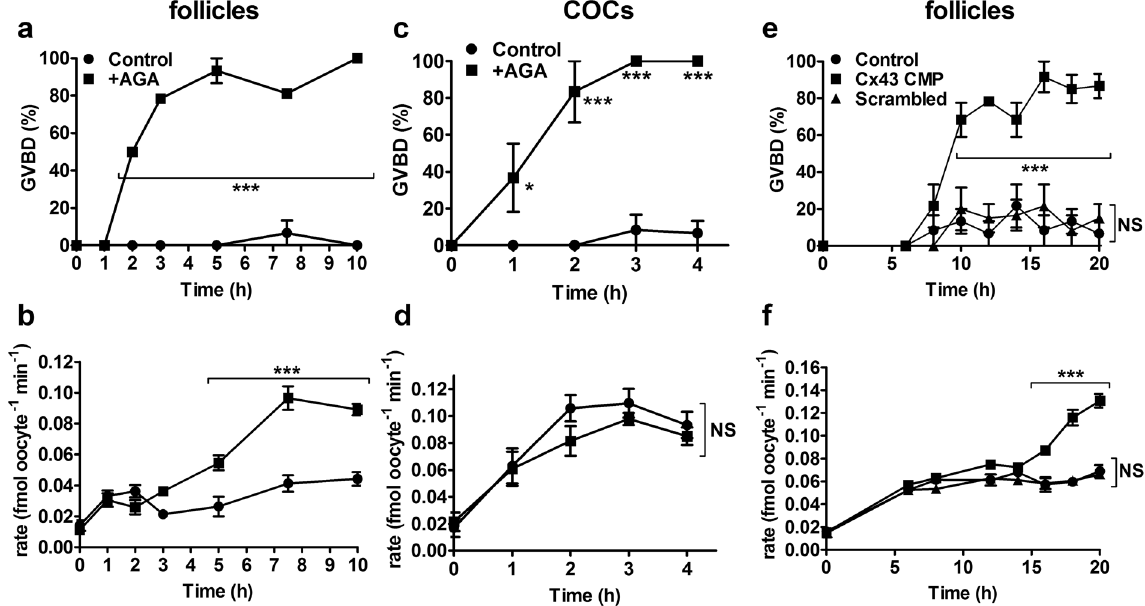
Figure 3. Effect of blocking gap junction permeability on GLYT1 activation. ( a ) Time course of GVBD in oocytes isolated from punctured antral follicles that had been cultured for the period indicated in the presence or absence of the gap junction blocker, AGA (150 µ M). Means were significantly different for all time points from 2–10 h inclusive. ( b ) GLYT1 activation as a function of time in the presence or absence of AGA in the same oocytes as in ( a ). GLYT1 activity was significantly increased starting at 5 h, with partial activation at 5 h and full activation at 7.5 and 10 h. Each point represents the mean ± s.e.m. of three independent repeats at each time (in A and B). ( c ) Time course of GVBD in oocytes isolated from COCs cultured with or without AGA identically to the antral follicles in ( a ). Significant GVBD occurred starting at 1 h and was maximal by 2–3 h. ( d ) GLYT1 activity in the same oocytes as in ( c ). There was no significant difference in the presence vs. absence of AGA. Each point represents the mean ± s.e.m. of three independent repeats at each time (in c and d ). ( e ) Time course of GVBD in oocytes isolated from punctured antral follicles in the presence of no addition (Control), Connexin Mimetic Peptide directed against Connexin 43 (Cx43 CMP) or a scrambled peptide. GVBD was significantly increased only by 10 h only in the Cx43 CMP treated group. ( f ) GLYT1 activity in the same oocytes as in ( e ) did not increase significantly until starting at 16 h only in the Cx43 CMP group. Each point represents the mean ± s.e.m. of three independent repeats at each time (in e and f ). Throughout ( a–f ), data were analysed by 2-way ANOVA (overall effect between treatments: P < 0.0001 for a,b,c,e,f ; P = 0.18 for d ) with